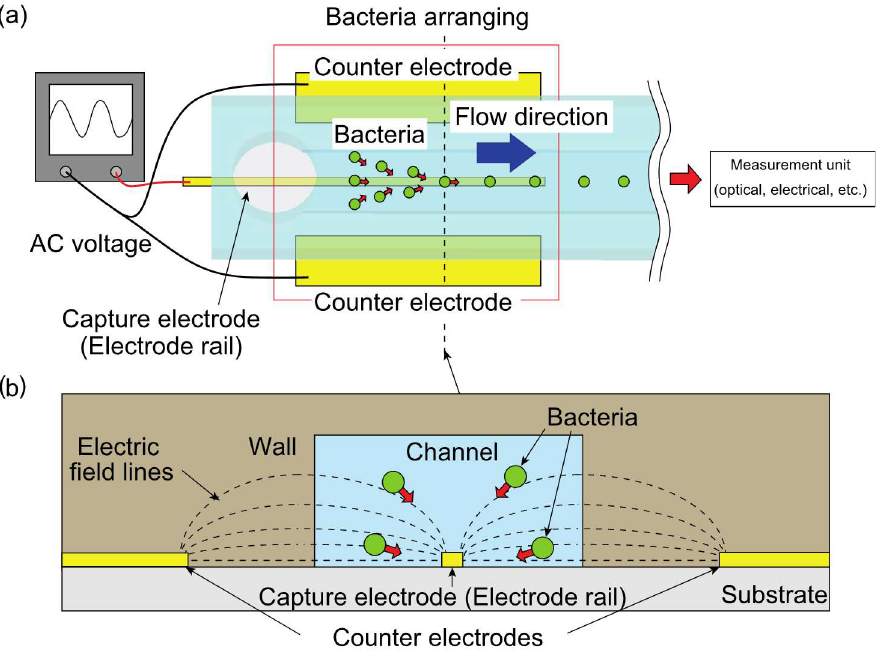
Figure 1. Schematic of the device used to form a line of bacterial cells: ( a ) top view of the device and connection of the AC power source to the electrodes and ( b ) cross-sectional view of the device. The dotted lines indicate the electric field lines which pass through the microchannel wall, creating a large electric field gradient to generate dielectrophoresis (DEP). Bacteria are attracted on the capture electrode (electrode rail).